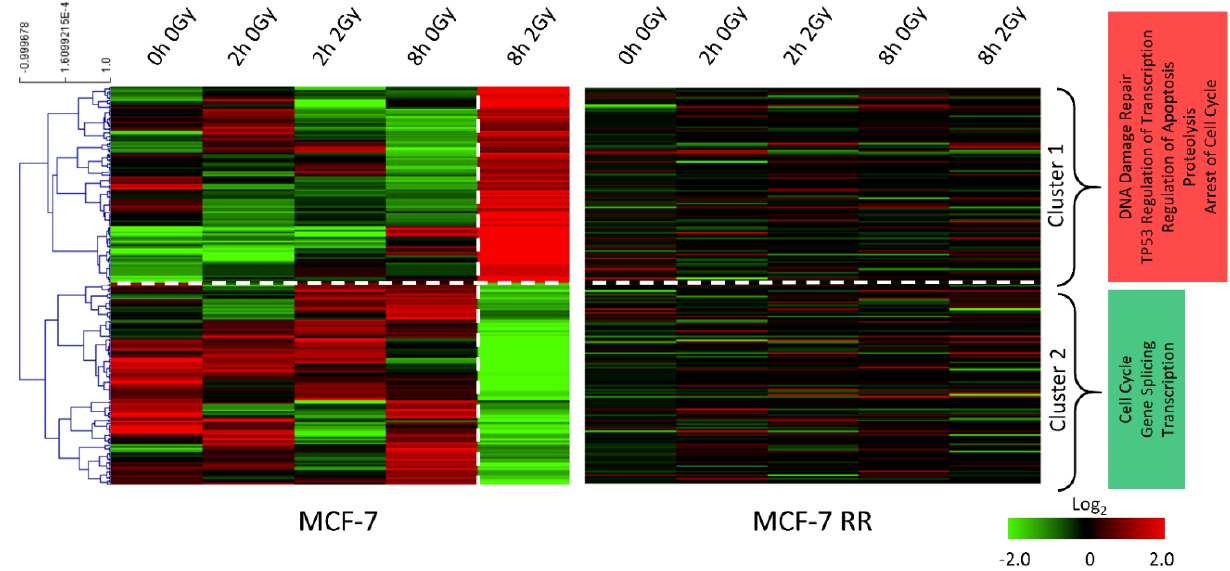
Figure 5. MCF7 and MCF-7 RR gene expression changes associated with response to radiation. Heatmaps reflect log 2 mean-centred gene expression changes with clustering based on Pearson correlation with average linkage (red = higher expression, black = no change, green = lower expression). Radiosensitive MCF-7 parental cells and their RR derivatives are shown in adjacent heatmaps. For each cell line, untreated baseline controls at 0 h are shown along with both the treated (2 Gy radiation) and untreated controls at 2 h and 8 h. The genes shown are the most differentially expressed in sensitive parental MCF-7 cells, with the largest gene expression differences seen between the untreated controls and the 2 Gy treated cells at 8 h.